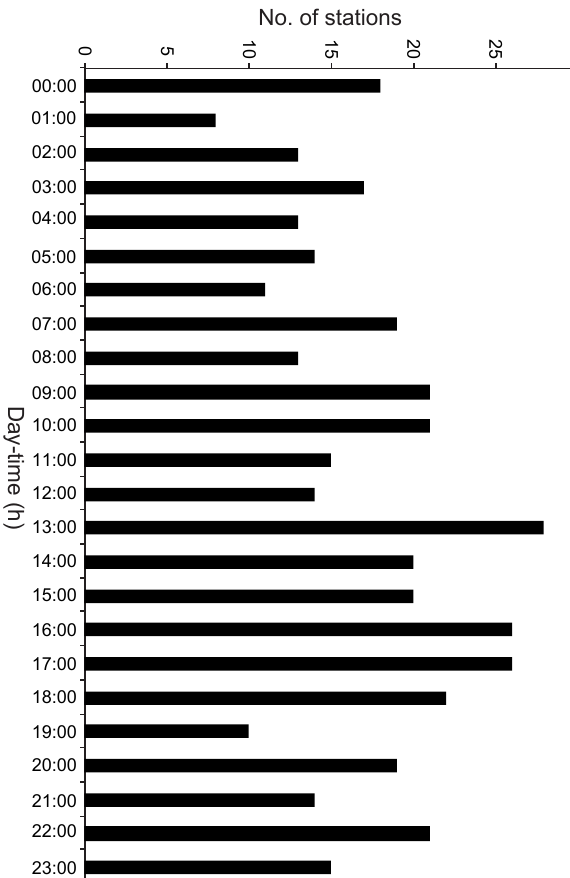
Figure 3. Sampling effort during day-time in the Southern Ocean. Day-time is important to understand the behaviour of diel vertical migrators. The number of stations is summarized for every hour of the day, e.g. the bar at 00:00 contains all stations taken between 00:00 and